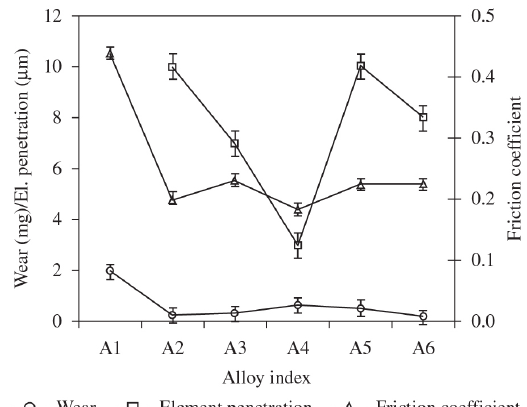
Figure 2. Wear and friction coefficient achieved for the treated alloy